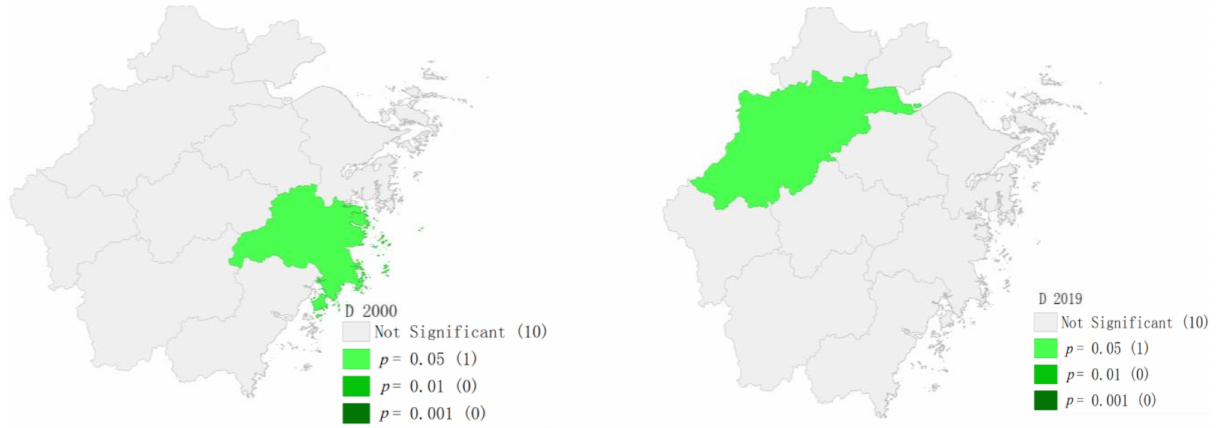
Figure 7. Local spatial correlation map of cities in the Zhejiang Province in 2000 and 2019.